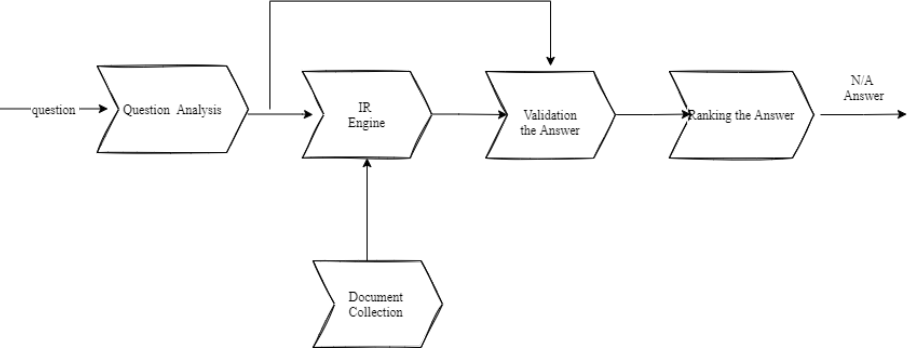
Figure 6. Design of an IR/IE-based